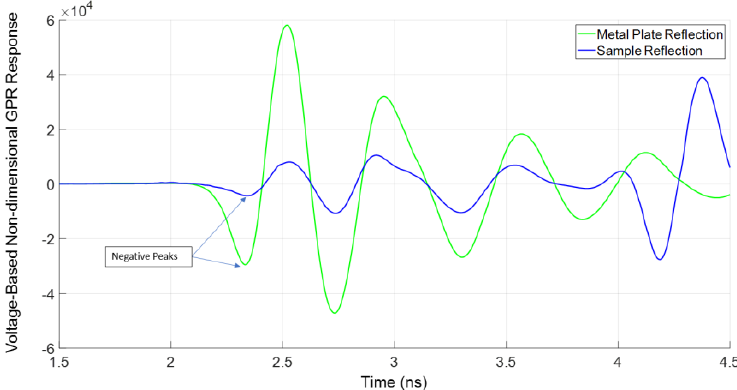
Figure 10. Reflection waveforms from the metal plate and sample following subtraction of the background measurement.